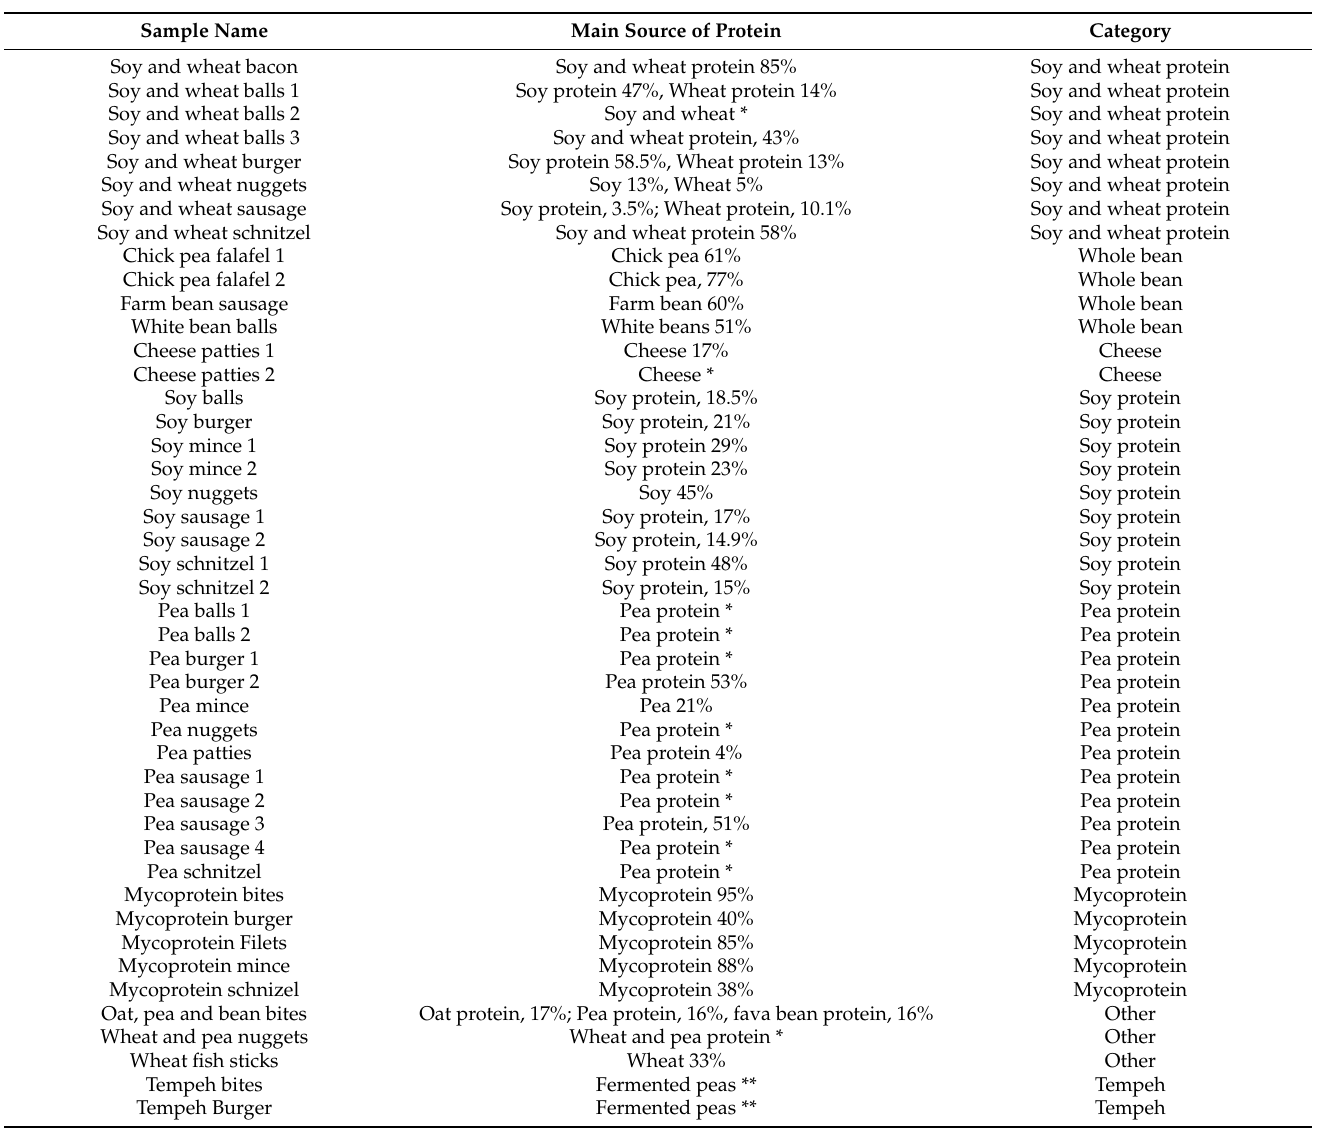
Table 1. Overview of meat substitutes analyzed in this